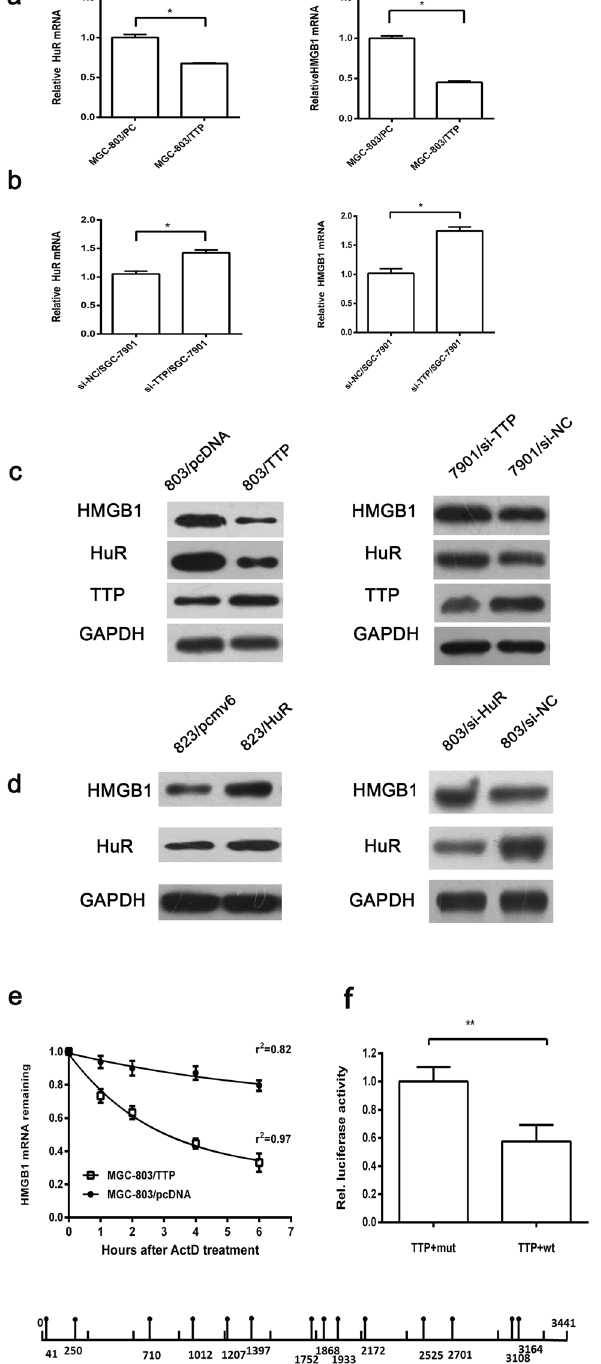
Figure 2. HuR was downregulated by TTP, and dysregulation of TTP and HuR regulated the expression of HMGB1 in different ways. ( a – c ) TTP regulated the expression of HuR and HMGB1 at the mRNA level. ( d ) HuR upregulated the expression of HMGB1 at the translational level. ( e ) The HMGB1 mRNA decay curve in actinomycin D-treated MGC-803/TTP and MGC-803/pcDNA cells. The half-life of HMGB1 mRNA in MGC-803/TTP cells was shorter than that in MGC-803/pcDNA cells after 6 hours of actinomycin D treatment. The data were represented as the mean ± SD, r 2 : goodness of fit, ** p < 0.01. ( f ) Luciferase assay in 293 T cells revealed that AREs within the HMGB1 mRNA 3 ′ UTR mediated the inhibitory of TTP. And the schematic showed the potential binding sites of TTP within the HMGB1 mRNA 3 ′ UTR. Results shown on the graph represent the mean ± S.D. of three independent experiments, ** p <